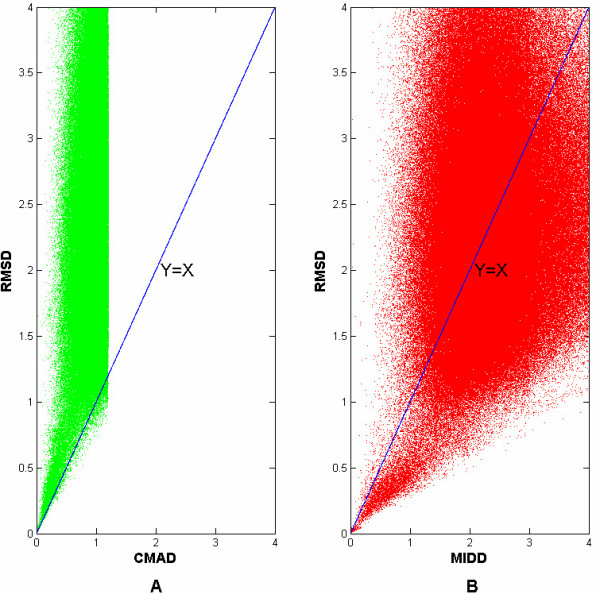
The relationship between CMAD, MIDD and RMSD. A: relationship between the CMAD and the RMSD. Each dot represents a pair of the CMAD and the RMSD. The relationship was only showed when the CMAD< = 1.2Å, because the CMAD cutoff was set as 1.2Å. The green line represents the line of Y = X. B: relationship between the MIDD and the RMSD, The green line also represents the line of Y = X.